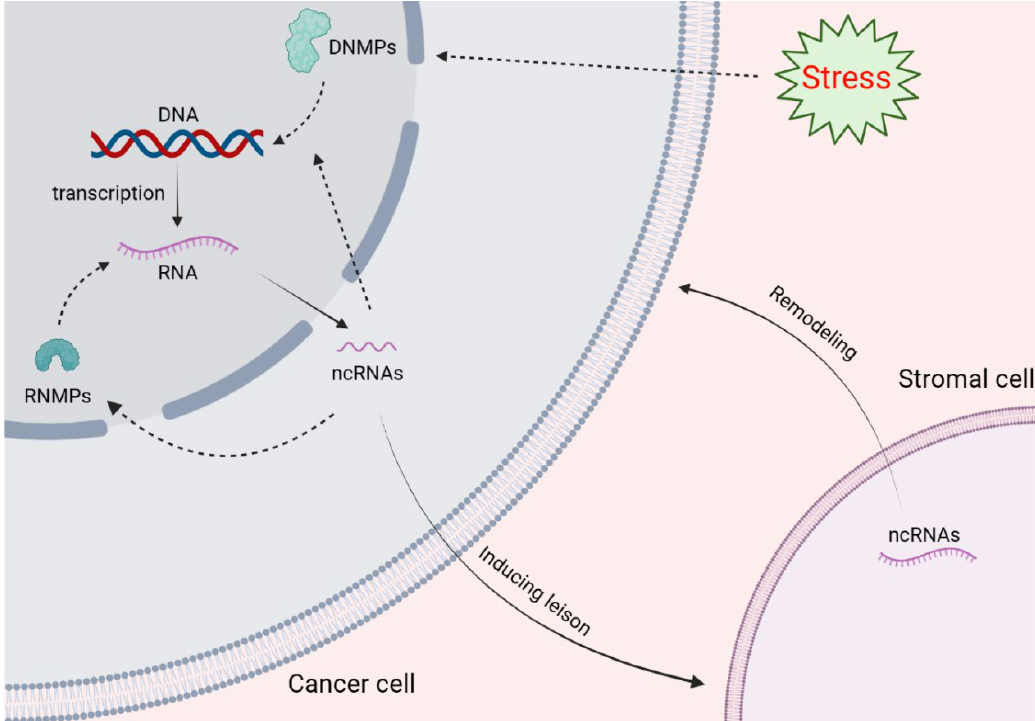
Figure 1. Schematic diagram of epigenetic regulation in the microenvironment. To respond to ex- ternal stresses, tumor cells are usually regulated in a manner of chromatin regulation, such as DNA methylation, histone modifications, nucleosome localization, and changes in high-grade chromatin conformation. This process not only affects the gene remodeling of tumor cells, but also has a huge effect on cell metabolism and epitranscription. Similarly, as an intermediate process between “re- sponse” and “effect”, RNA modification also plays an essential role in tumor cell adaptation and survival. The ncRNAs generated under RNA modification are not only involved in the commu- nication between cancer cells and stromal cells, but are also involved in the process of epigenetic modification. DNMPs—DNA modification proteins; RNMPs—RNA modification